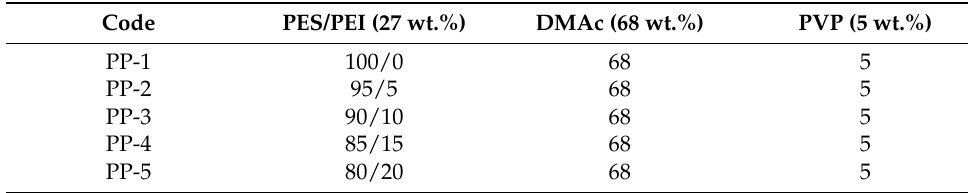
Table 3. The specific ratio of casting solution.